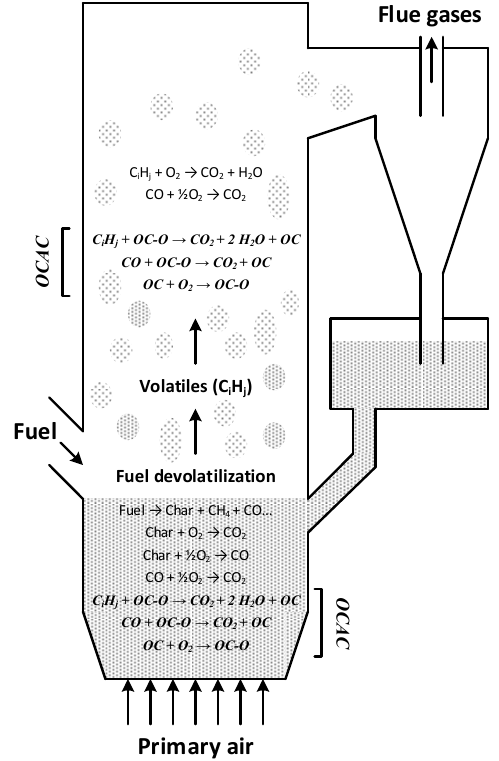
Figure 1. Schematic illustration of Oxygen Carrier Aided Combustion (OCAC) in Circulating Fluidized Bed (CFB) boiler. Simplified bulk reactions in dense bed and freeboard have been included, with new significant reaction pathways in italic. OC–O = oxidized oxygen carrier, OC = reduced oxygen carrier.